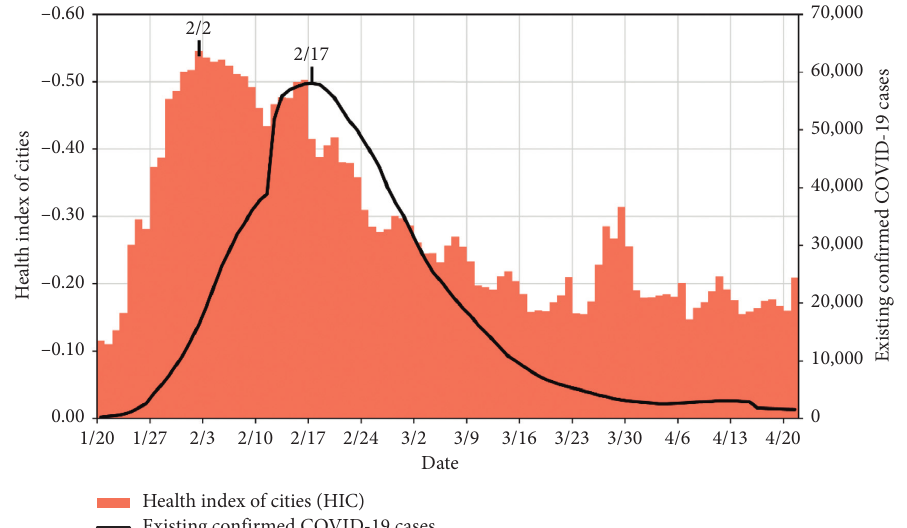
Figure 3: Daily variation in the health index of cities and existing confirmed COVID-19 cases in China. The HIC here is the average of all.